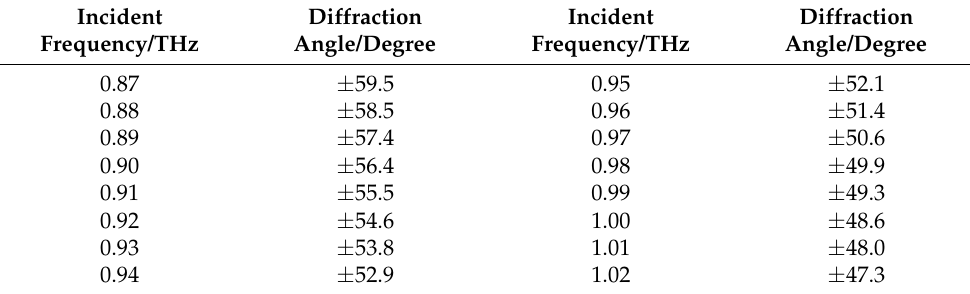
Table 1. Diffraction angles calculated at different incident wave frequencies.